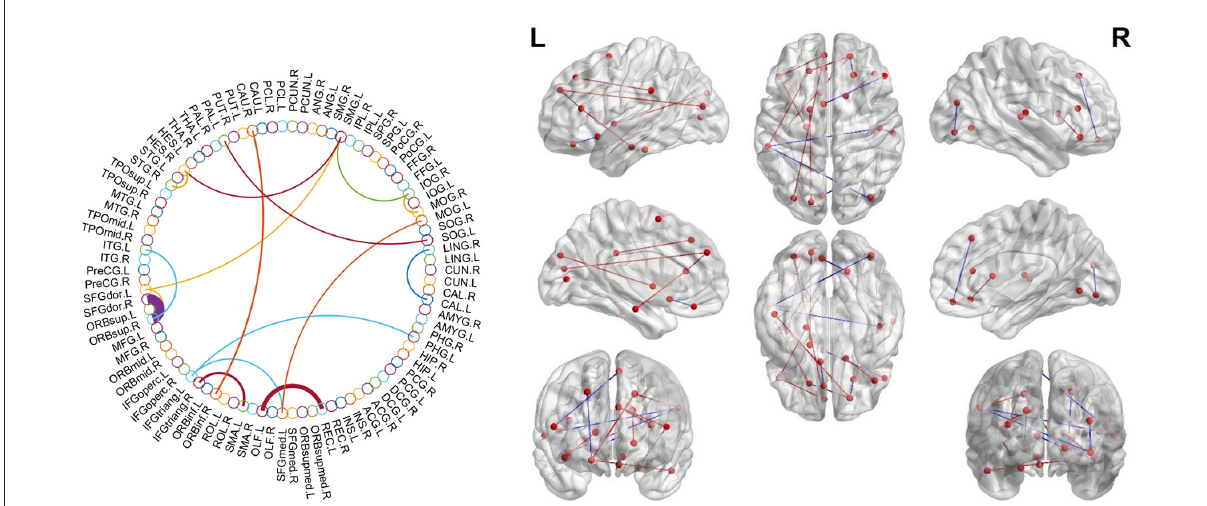
FIGURE3 Theconsensusconnectionsofthemorphologicalbrainnetwork.Left:theconsensusconnectionsofthemorphologicalbrainnetworkselectedby leave-one-out cross-validation (LOOCV) in the subjective cognitive decline (SCD) and normal control (NC) groups based on AAL90. The thickness of an arc in the circle indicates the discriminative power of an edge, which is inversely proportional to the estimated P-values. The colors were randomly generated to differentiate regions of interest (ROIs). Right: the consensus connections selected by LOOCV. The connections were mapped on the ICBM 152 template with the BrainNetViewer package (http://nitrc.org/projects/bnv/). Blue and red represent the decrease and increase of morphological connection weight of SCD groups, respectively.